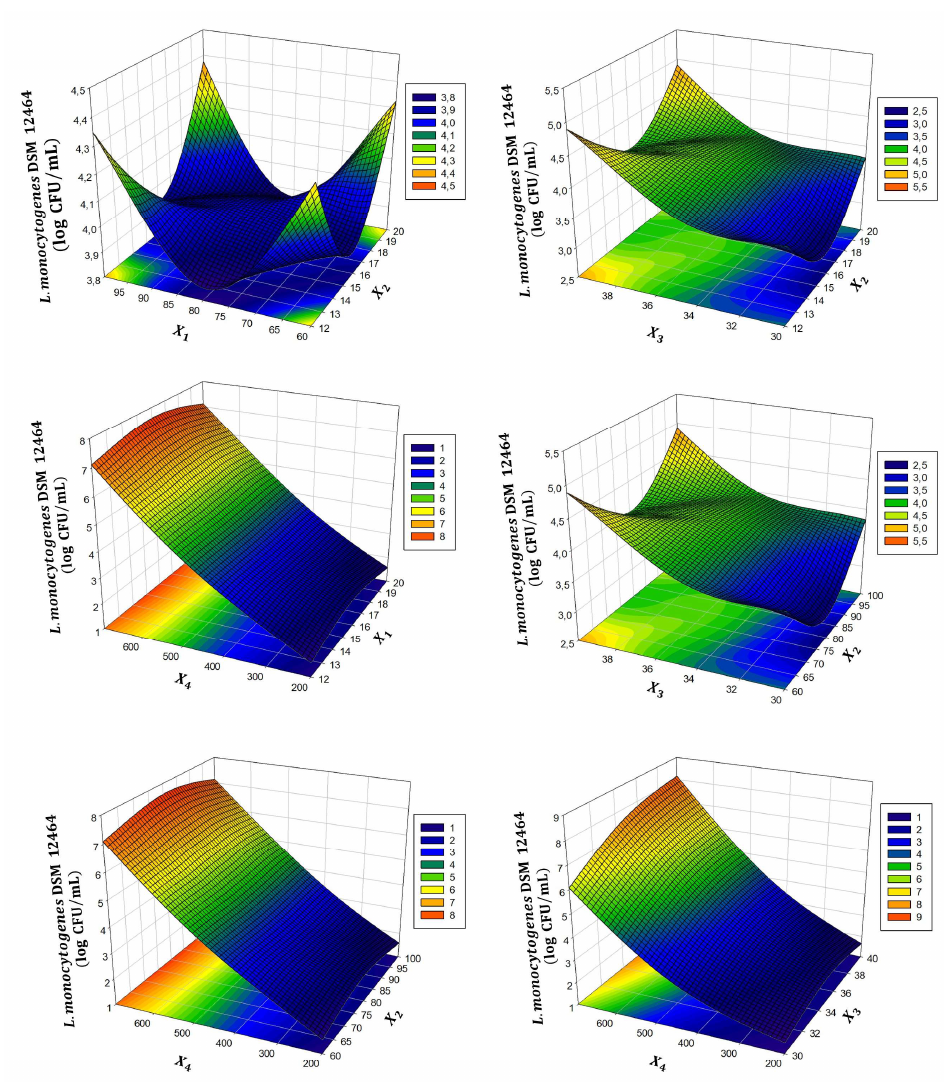
Figure 4. Three-dimensional response surface plots representing the effect of process variable on L. monocytogenes DSM 12464: (X 1 ) ultrasound time (min); (X 2 ) ultrasound amplitude (%); (X 3 ) microwave time (s); (X 4 ) microwave power (W). As shown in Table 2, the treatment of 20 min, 100 amplitude, 40 s, and 700 W had the highest inhibitory effects on the tested pathogens. Pathogen inactivation by ultrasound and microwave treatment has been investigated in many studies for liquid food safety [59–62]. In a sample group receiving 700 W microwave treatment, the numbers of L. mon- ocytogenes were not detectable after 35 s. In a study by Trujillo-Mayol et al. (2019), L. mon- ocytogenes was more sensitive to ultrasound–microwave-treated avocado peel extracts than S. aureus [63]. Similarly, in another study, L. monocytogenes was observed to become more sensitive to heat treatment after growth in an acidifying growth medium [64]. In addition, it can be seen in Table 2 that E. coli was the most resistant to ultrasound–micro- wave treatment than the other tested pathogens. In a previous study, the results showed that Salmonella Typhimurium and L. monocytogenes had lower heat resistance and acid adaptability compared to E. coli in orange juice [65]. Similarly, Mendes-Oliveria (2020) and Song and Kang (2016) observed that E. coli showed more resistance than Salmonella spp. to microwave heating [33,66]. It was also reported that the susceptibility of pathogens did not only depend on the use of treatment such as ultrasound, but was also affected by the food matrix [67]. The data in the literature on the effects of microwave treatment on the survival of microorganisms are vary because the process parameters are different [68]. In the literature, the primary mechanisms for microbial inactivation using ultrasound are acoustic cavitation and acoustic streaming. These mechanisms can inactivate pathogens by mechanical, thermal, and chemical effects [16]. Microwave, which carries out heating by converting electromagnetic energy into heat through selective absorption and dissipa- tion, differs from conventional heating by convection and conduction. There is no holding period because microwaves generate heat constantly [57]. Increasing the ultrasonic power and duration may cause the destruction of microorganism cells by ultrasonic waves. With increasing wave power, the number of bubbles formed in the liquid increases, and this causes an increase in cavitation, which explains the reason for the inhibition of pathogens.